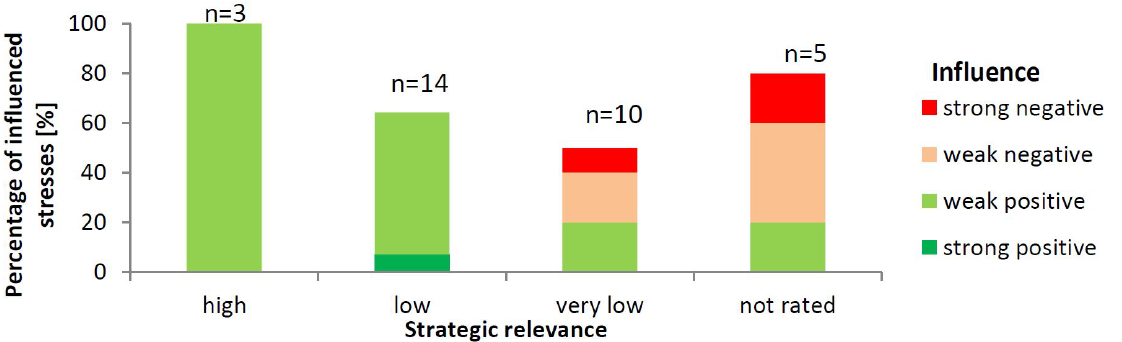
Figure 13. Influence of FSC strategies on stresses of different strategic